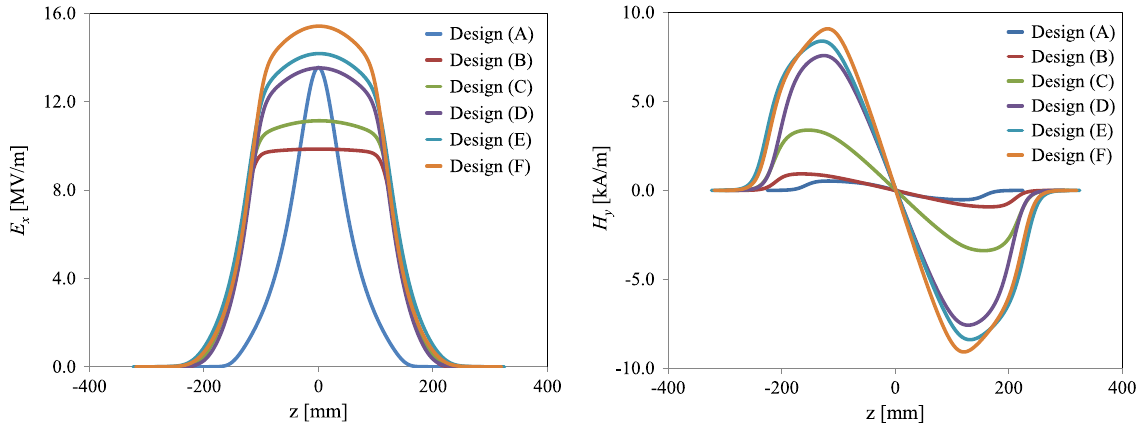
FIG. 27. On-axis electric (left) and magnetic (right) field of all parallel-bar designs shown in Fig. 8 normalized at a stored energy content of 1